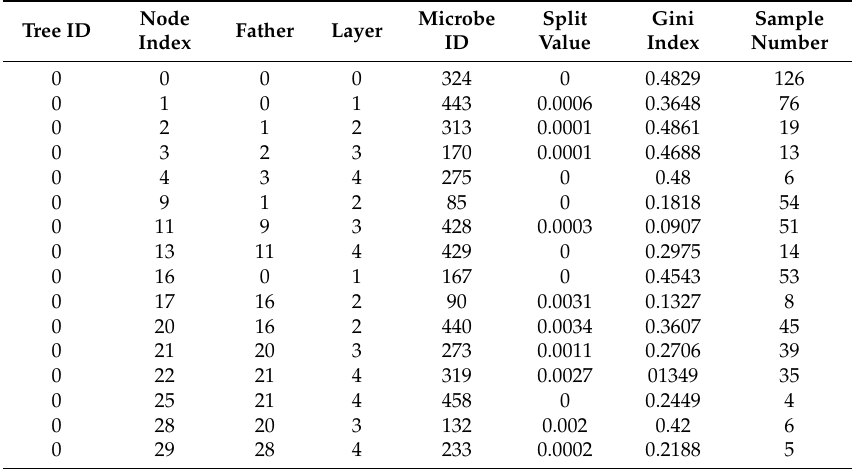
Table 1. Schematic diagram of node information in decision tree.